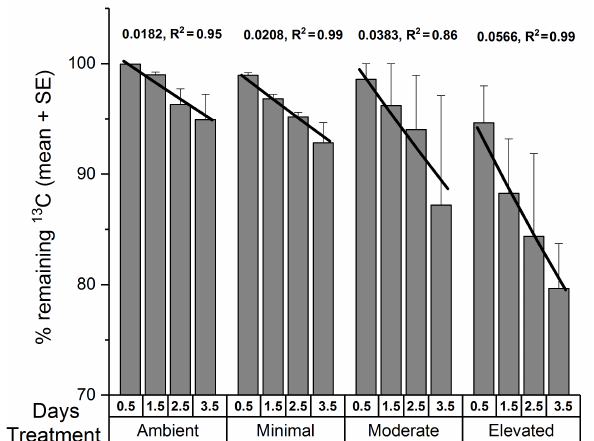
Figure 6. The percentage of 13 C remaining in sediment OC (0– 10cm depth; mean ± SE) from the calculated budget for total 13 C. Lines are exponential decay functions for each treatment across the 3.5 days of incubation (loss rate constant, R 2 of